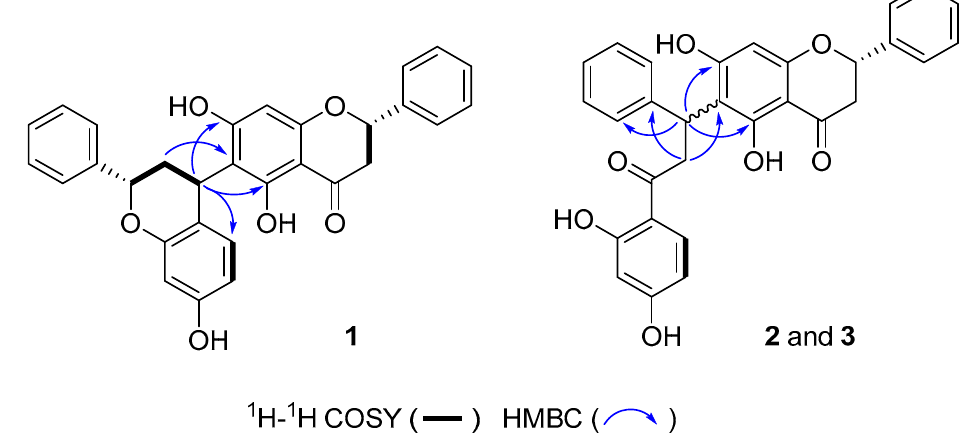
Figure 2. Key 1 H- 1 H COSY ( 1 H- 1 H Correlation Spectroscopy) and HMBC correlations of compounds 1 – 3 . Oxytrochalcoflavanones A ( 2 ) and B ( 3 ), yellow amorphous powders with the same molecular formula of C 30 H 24 O 7 based on the negative HR-ESIMS data, were also found to be biflavonoids. The UV, Table 1. 1 H-NMR and 13 C-NMR data for oxytrodiflavanone A ( 1 ) ( δ in ppm, J in Hz). ECD (Electric Circular Dichroism), 1 H and 13 C-NMR spectra of 2 and 3 (Table 2) were almost identical, but with the opposite optical rotations ([ α ] 20 D − 68.6 for 2 ; [ α ] 20 D + 51.9 for 3 ). The main No.